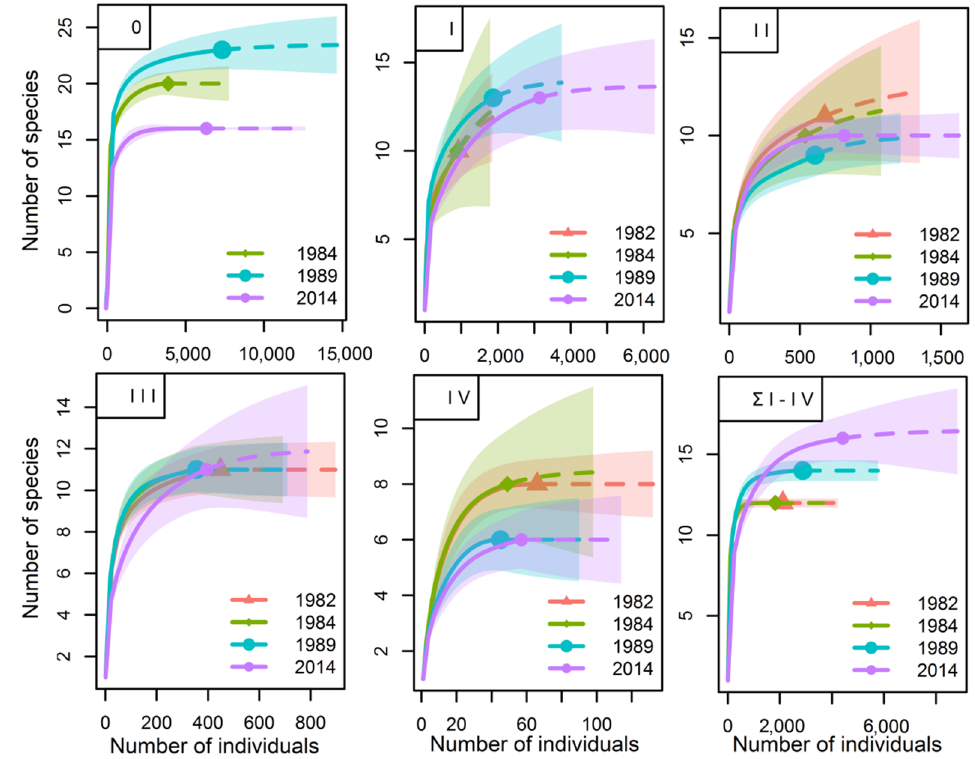
Figure 1. Sample-size-based rarefaction (solid lines) and extrapolation (dashed lines) of sampling curves with 95% confidence intervals (shaded areas). Observed (reference) samples are denoted by the solid dots. 0–IV – classes of trees.